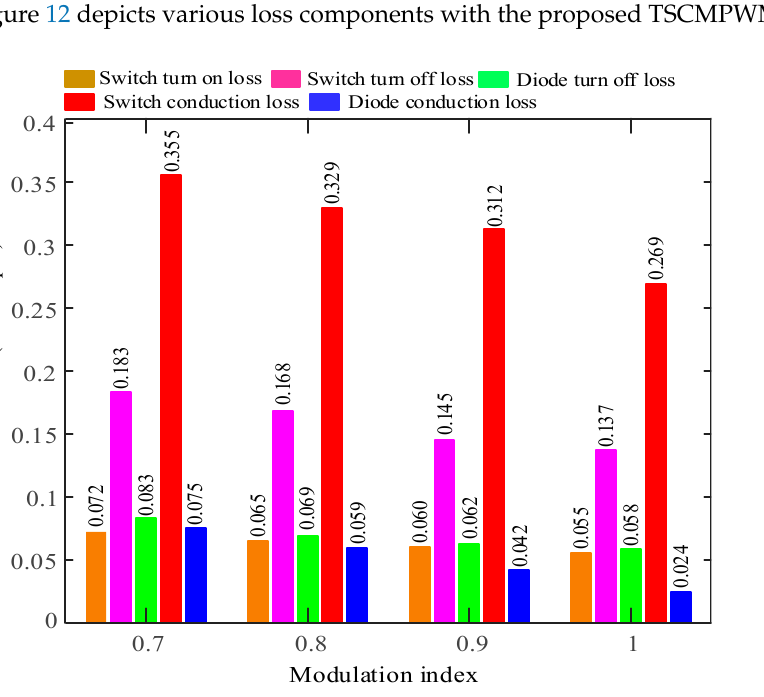
Figure 12. Power loss analysis against modulation index variation for the proposed TSCMPWM technique.